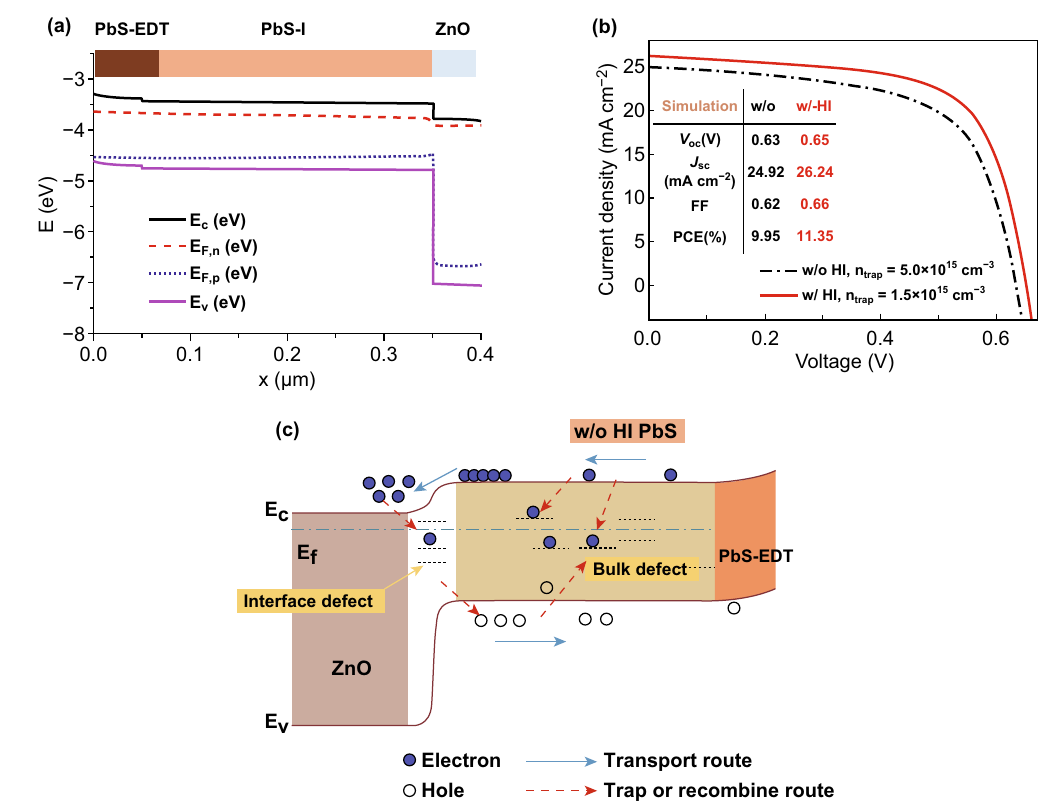
Fig. 7 a The energy band from SCAPS modeling for PbS‑QDs solar cell. b Current–voltage characteristics under AM 1.5G illumination for w/and w/o HI devices. c Schematic illustration of proposed photocarrier transport and transfer for w/o and w/HI devices based on simulation and device physics